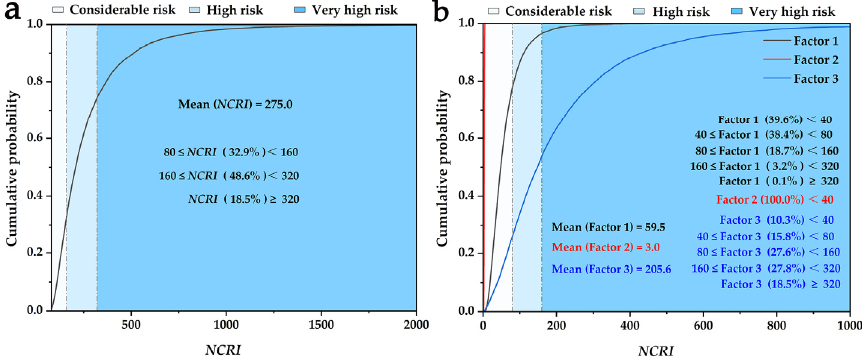
Figure 3. Cumulative probabilistic distribution of NCRI . ( a ) Concentration-oriented probabilistic risk assessment; ( b ) Source-oriented probabilistic risk assessment.